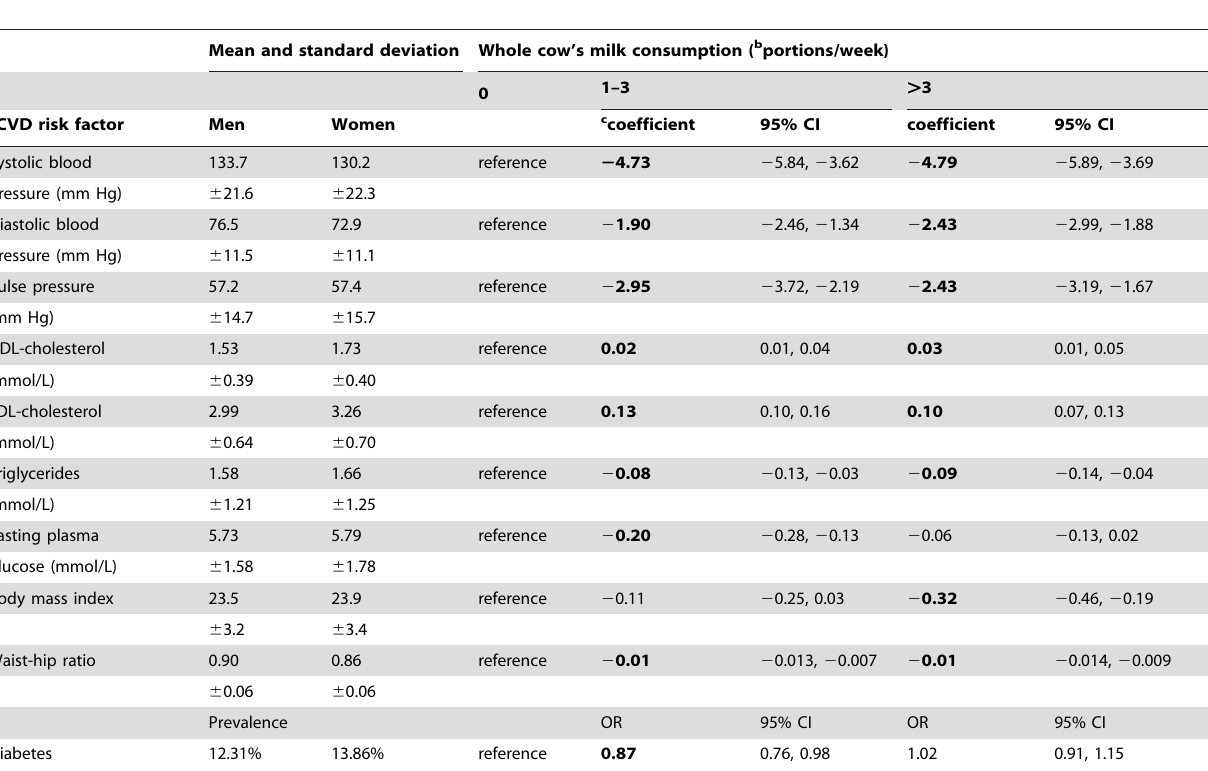
Table 2. Unadjusted Associations of Whole Cow’s Milk Consumption with Cardiovascular Risk Factors in Older Chinese (5853 men and 14,482 women) in Phases 1 and 2 of the Guangzhou Biobank Cohort Study, 2003–2006.